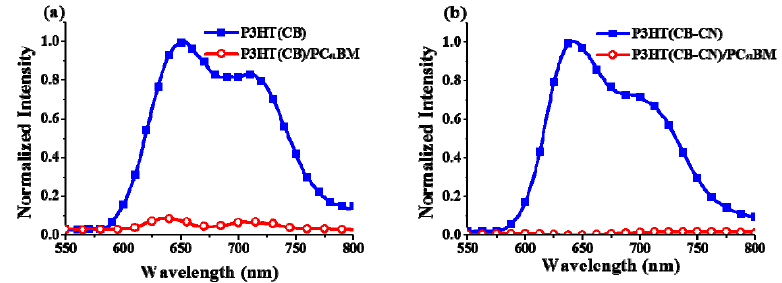
Figure 3. PL spectra of the P3HT and P3HT/PC 61 BM bilayer, ( a ) as-prepared P3HT(CB) bottom-layer (square) and P3HT(CB)/PC 61 BM bilayer (circle); and ( b ) as-prepared P3HT(CB-CN) bottom-layer (square) and P3HT(CB-CN)/PC 61 BM bilayer (circle).